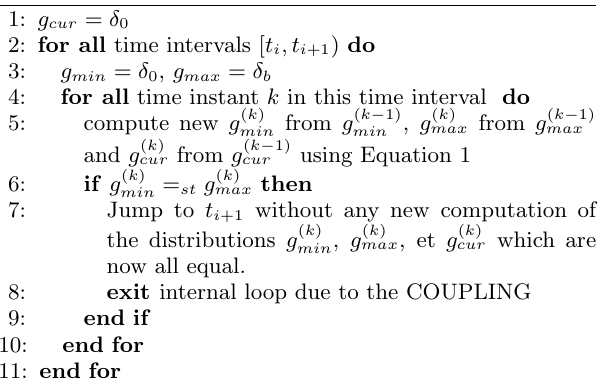
Algorithm 1 Computation with coupling detection